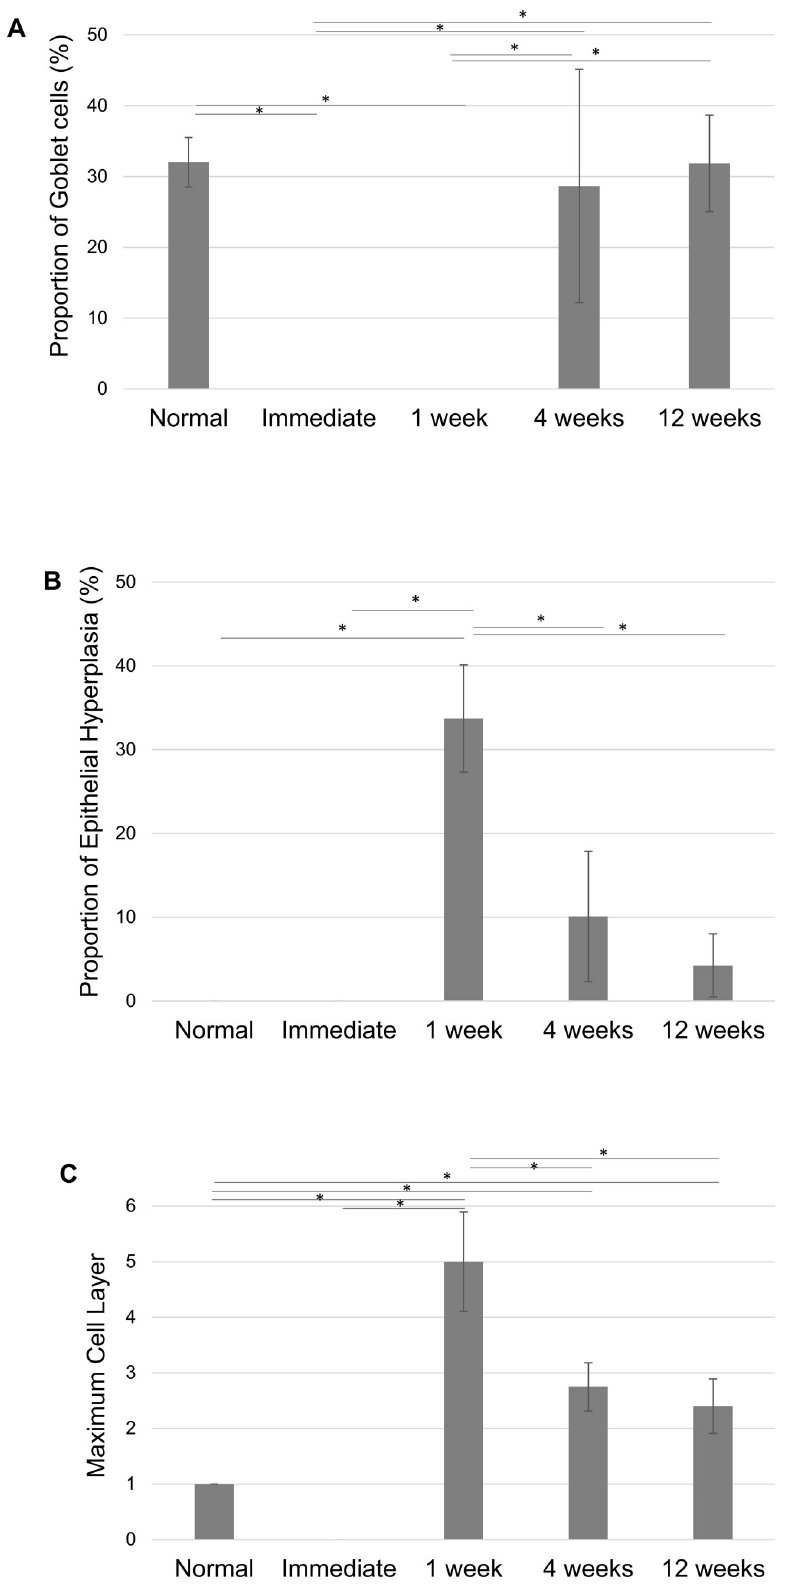
Fig 5. (A) Serial changes in the proportion of the goblet cells in the epithelium of the nasopharyngeal end of the rat ET. (B) Serial changes of the proportion of epithelial hyperplasia. (C) Serial changes of the maximum cell layer counts present in the epithelium of the cartilaginousend of the ET. � statistically significant differencesfor p < 0.05,Mann-Whitney U test. https://doi.org/10.1371/journal.pone.0268763.g005 PLOS ONE | https://doi.org/10.1371/journal.pone.0268763 May 25,